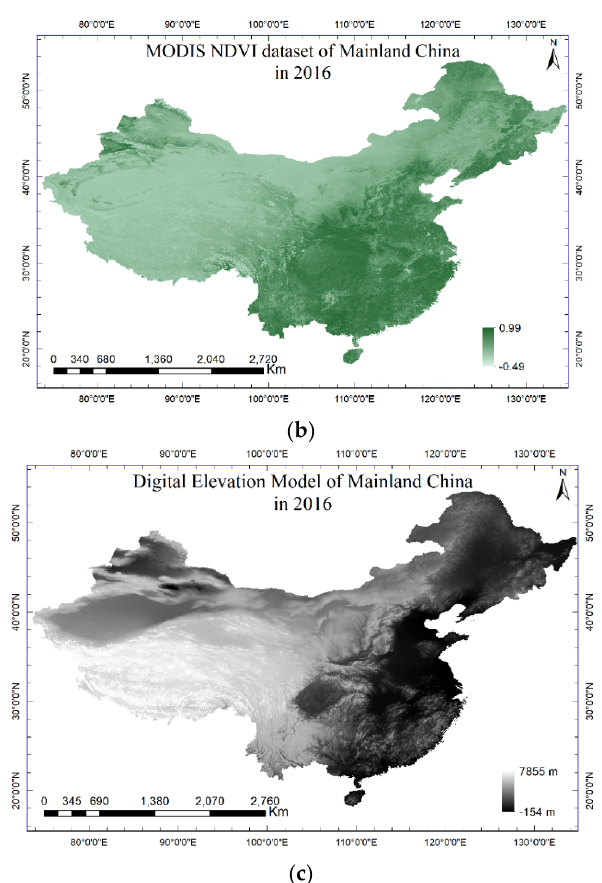
Figure 2. The geographical datasets: ( a ) VIIRS DNB nighttime annual stable lights in 2016; ( b ) MODIS NDVI product in 2016; and ( c ) Digital Elevation Model (DEM) dataset in 2016.